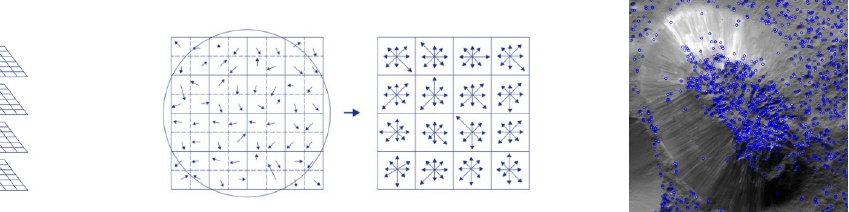
Figure 4. Left: After the Gaussian blur operator is applied for every pixel, we obtain the difference of Gaussians (DoG) (right), which will be helpful to identify the keypoints (red dots) of images of both Crater B and Ahuna Mons. Centre: Each keypoint has a location, scale, and orientation and is computed as a descriptor for the local image region about each keypoint that is highly distinctive and as invariant as possible (angle and luminosity). The keypoint descriptor is obtained using set of 16 histograms for the 4 × 4 grid of image with eight orientation bins for each grid item in the direction of candidate orientation, resulting in a feature vector of 128 units in size. Right: Keypoint dot analysis for the SIFT algorithm on the sample Ahuna Mons image. Left and centre images reprinted/adapted with permission from [28,29].